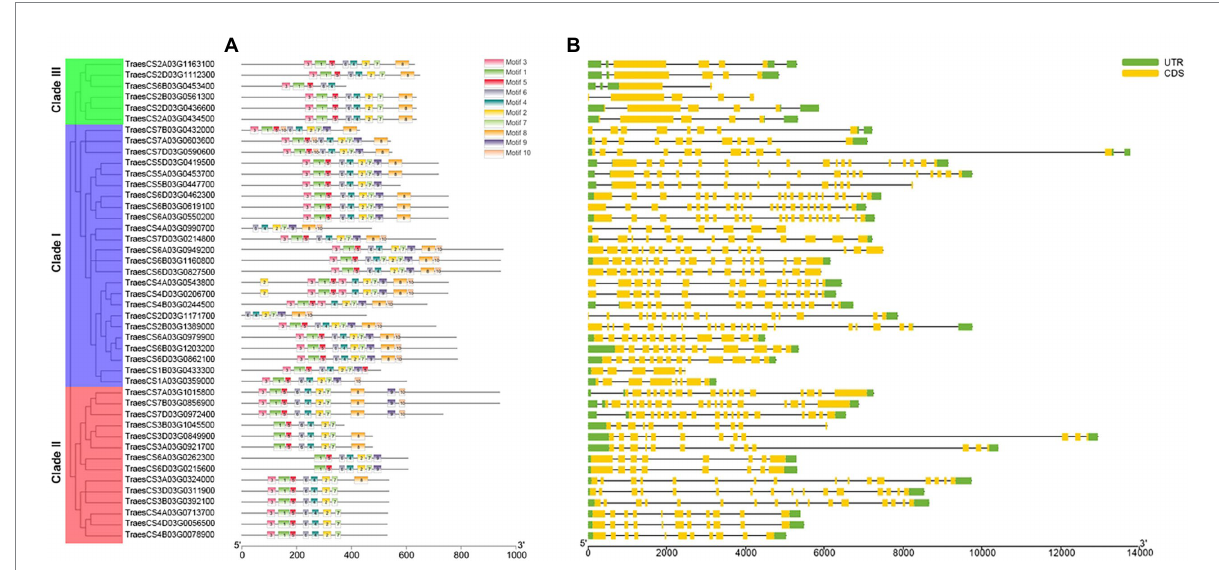
FIGURE 2 The motif and exon-intron structure of wheat ABC1K gene family members. (A) Conservative motifs of TaABC1K proteins. (B) Exon-intron structures of TaABC1K gene